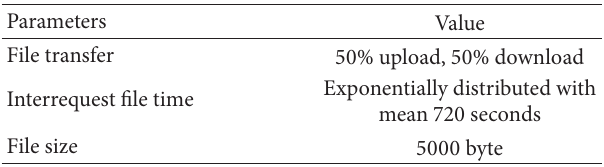
Table 6: The traffic model for FTP application.